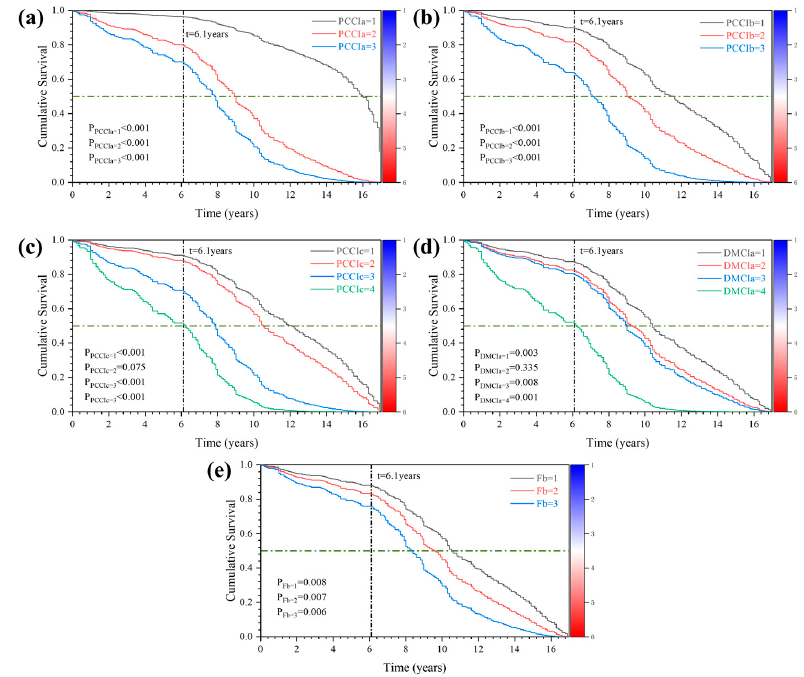
Figure 8. Cox survival curve: ( a ) Cox survival curve of PCCIa ; ( b ) Cox survival curve of PCCIb ; ( c ) Cox survival curve of PCCIc ; ( d ) Cox survival curve of DMCIa ; ( e ) Cox survival curve of Fb.